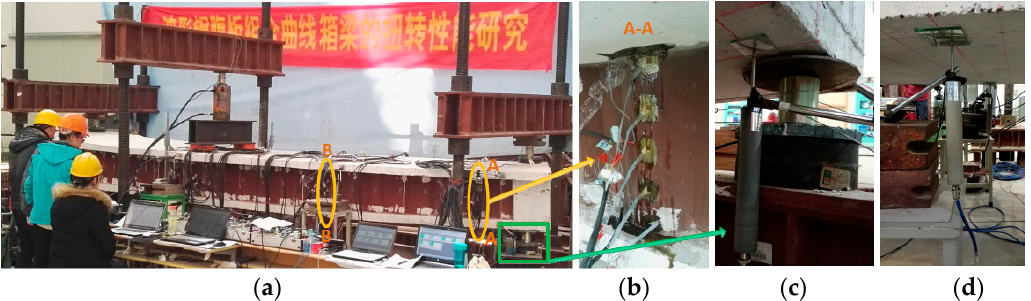
Figure 10. Photograph of the test setup: ( a ) Test setup; ( b ) Strain gauge configurations on CSWs; ( c ) Load transducers on supports; ( d ) Displacement transducers.